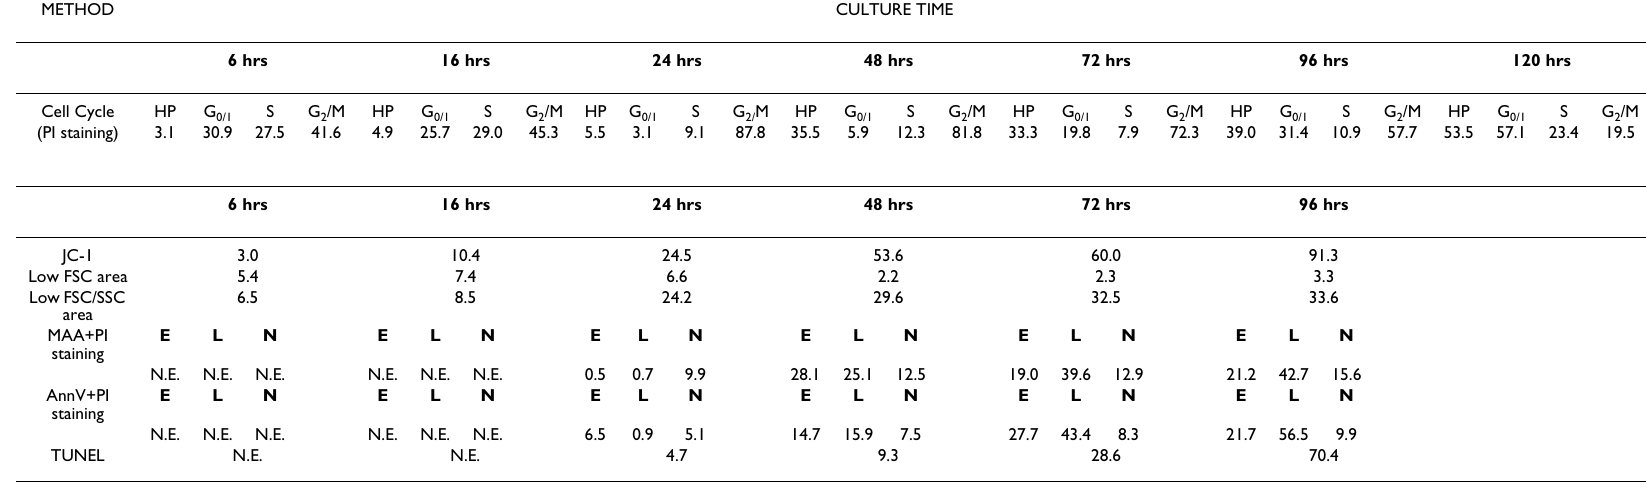
Top table: untreated (control) HT1376 bladder carcinoma cultures. Bottom table: HT1376 bladder carcinoma cultures were treated for 1 hour with 3 µ g/mL docetaxel, after which the drug was